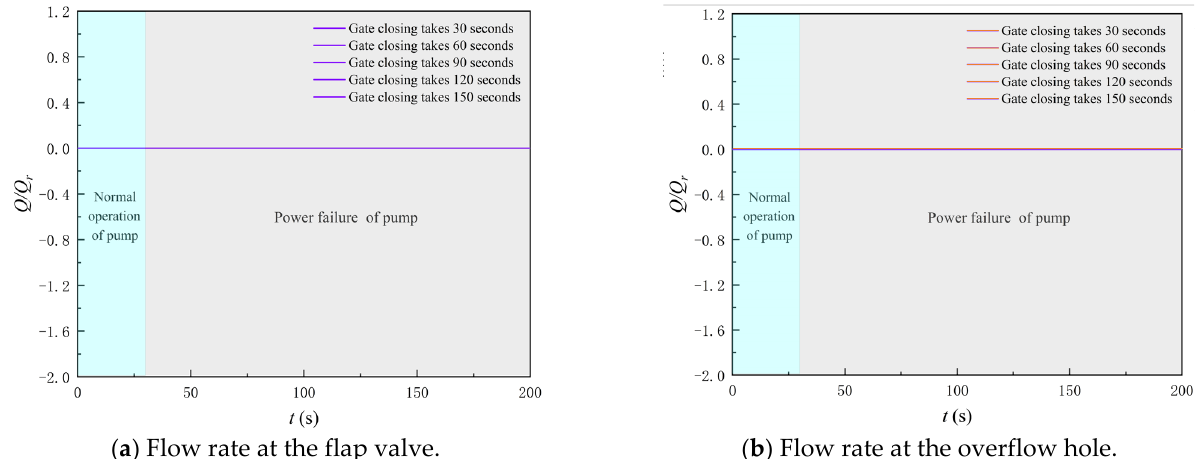
Figure 14. Flow at the flap valve and overflow hole at different gate closing speeds.